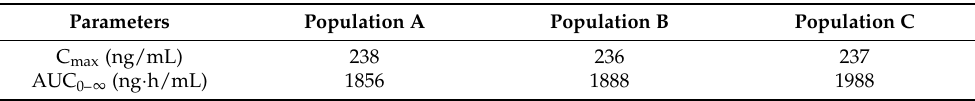
Table 9. Summary in vivo pharmacokinetic profile of Xarelto IR tablet (20 mg Strength) for Popula- tions A, B, and C in fed